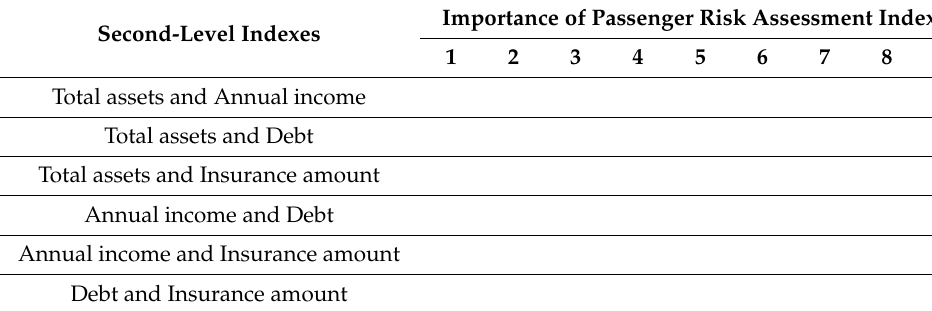
Table A4. Second-level indexes (economic situation).